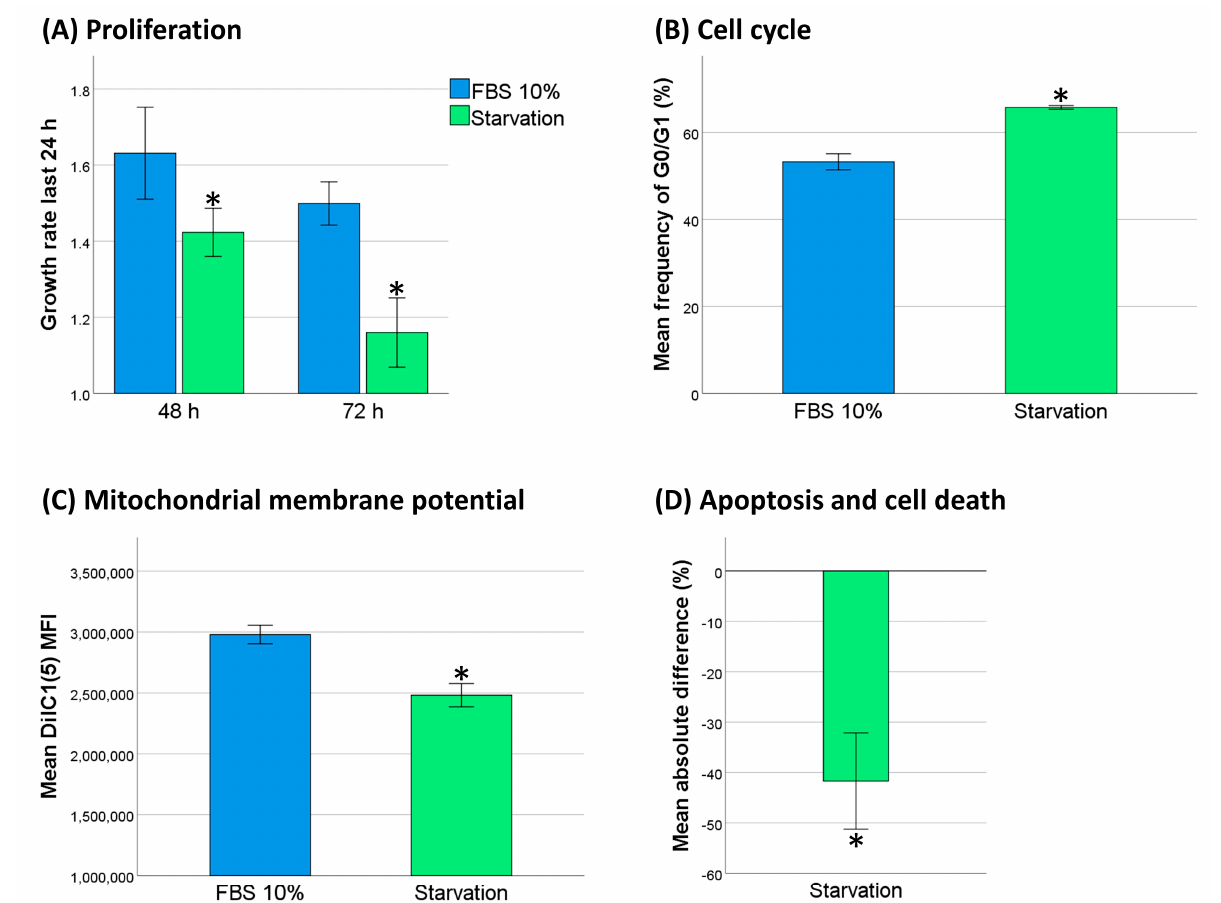
Figure 4. Effects of serum starvation on cell activity and daunorubicin (DNR)-resistance in THP-1 cells. ( A ) Daily proliferation rate analyzed by flow cytometric counting ( n = 4). ( B ) Cell cycle analysis after 48 h of serum starvation ( n = 3). Cells in the G0/G1 cell phase were gated. ( C ) Mitochondrial membrane potential after 48 h of serum starvation ( n = 3), mean fluorescence intensity (MFI) data. ( D ) Difference in DNR-induced cell death and apoptosis after 48 h of serum starvation compared to standard conditions. ( A – C ) were compared using the paired-sample t test. ( D ) was compared using the one-sample t test (test value = 0). * p < 0.05.